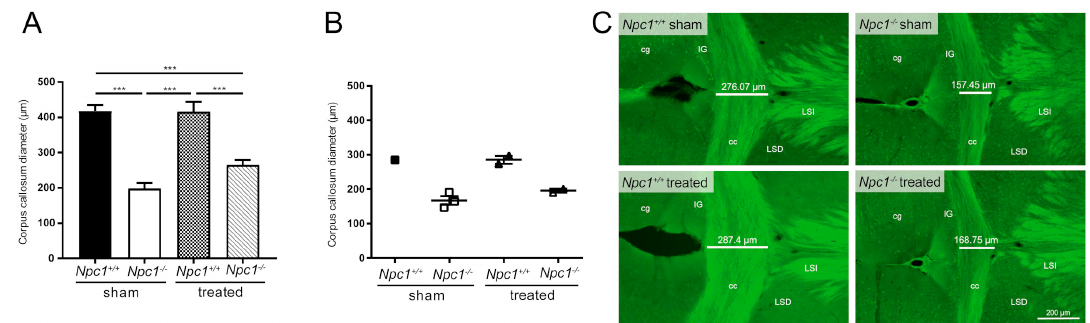
Figure 5. Morphometric analysis of the corpus callosum diameter from Nissl-stained brain sections sham-treated and treated Npc1 - / - and Npc1 +/+ mice ( A ). Sham-treated Npc1 - / - mice showed of sham-treated and treated Npc1 -/- and Npc1 +/+ mice ( A ). Sham-treated Npc1 -/- mice showed significantly reduced corpus callosum diameter compared to the respective Npc1 +/+ mice.